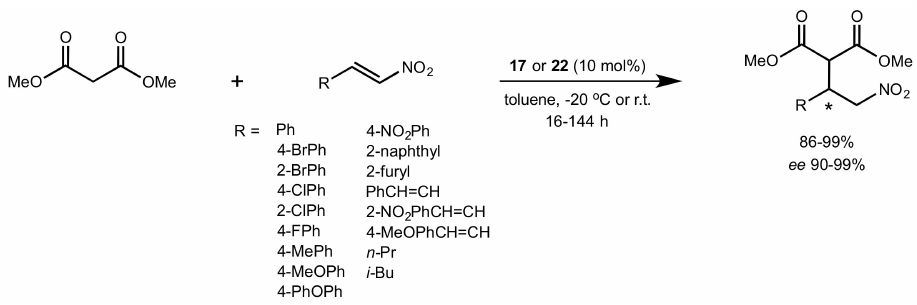
Figure 2. The structure of organocatalysts 17–22 . The best result (99% yield and 99% ee ) was observed for the catalyst 22 containing the di- n -butyl (1 S ,2 S )-1,2-diaminocyclohexane and β - D -glucopyranose moieties, using 10 mol% organocatalyst load and toluene as the solvent and performing the reaction at room temperature (Scheme 5). However, the time required to complete the reaction was long. On the other hand, similar yield and stereoselectivity but faster rates were observed when the catalyst 17 was used at − 20 ◦ C.